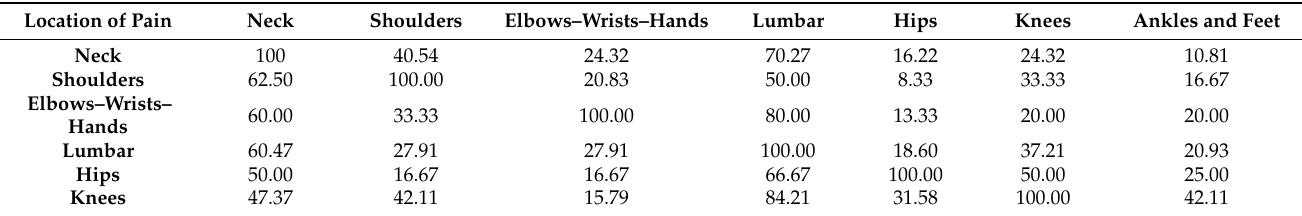
Table 3. Coexistence of musculoskeletal pain (%) among different anatomical